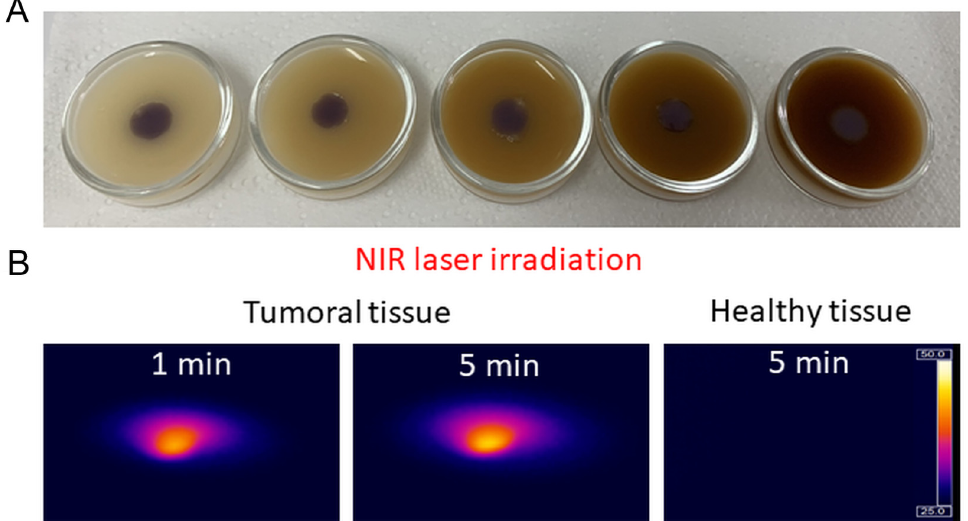
Figure 6. ( A ) Different skin tones biological phantoms which mimic a tumoral region and the surrounding healthy tissue. ( B ) Temperature contrast images of the NIR laser irradiated tumoral and healthy tissue phantoms.